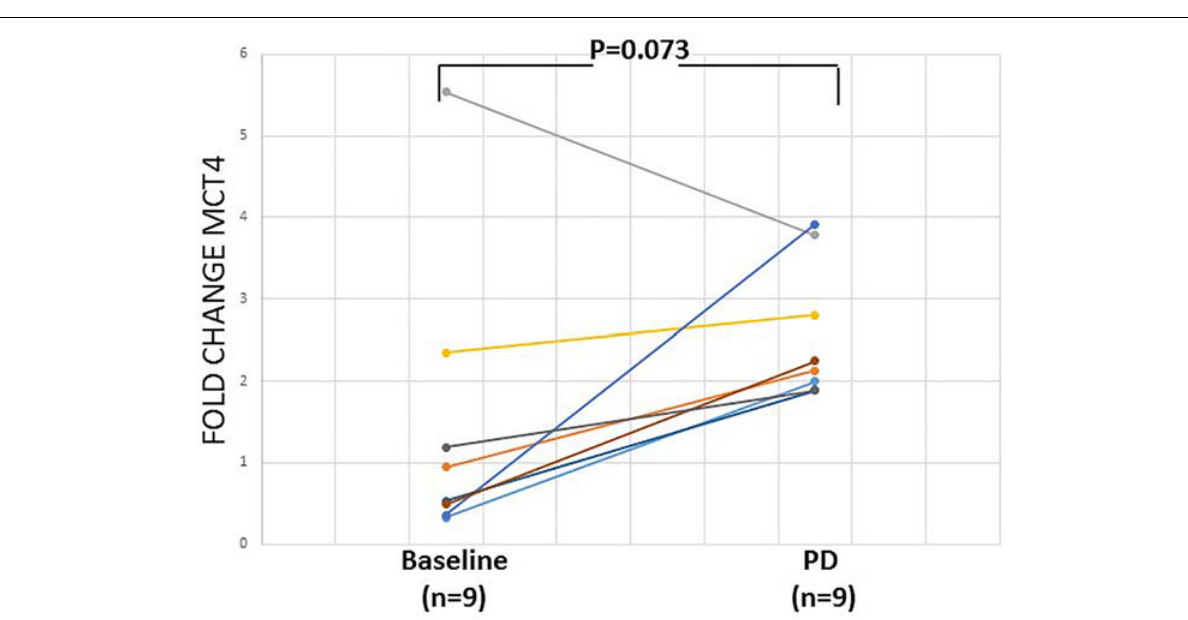
FIGURE 4 | Relative fold change (2 − (cid:49)(cid:49) Cq ) of MCT4 i n CTCs of 9 pairs of early stage NSCLC patient samples at the baseline and at the time of